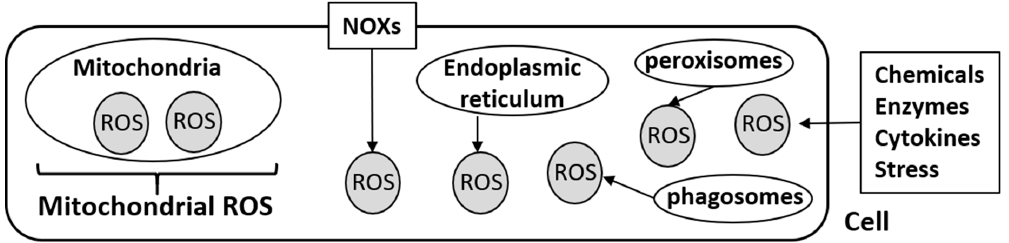
Figure 1. Mitochondrial reactive oxygen species (mROS) and intracellular ROS.